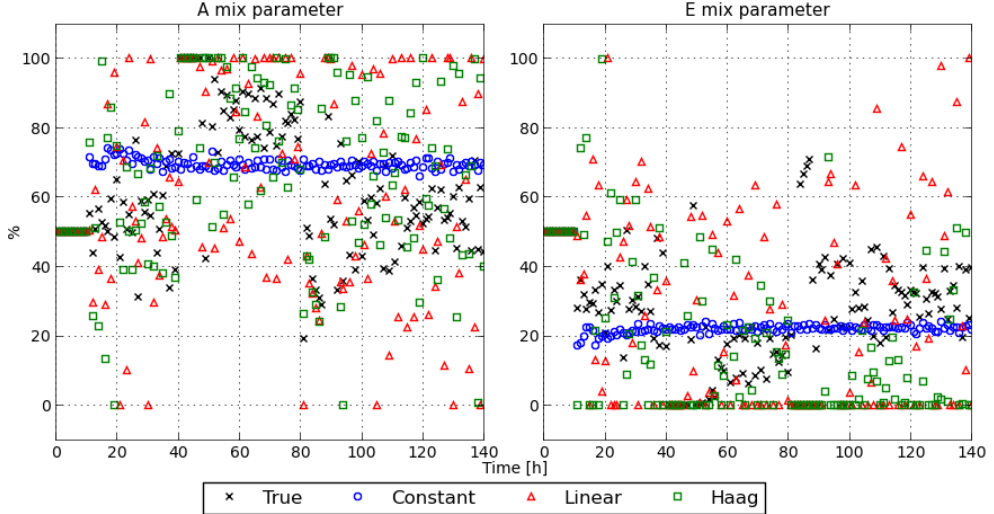
Figure 8. MPC control actions obtained with the different flux